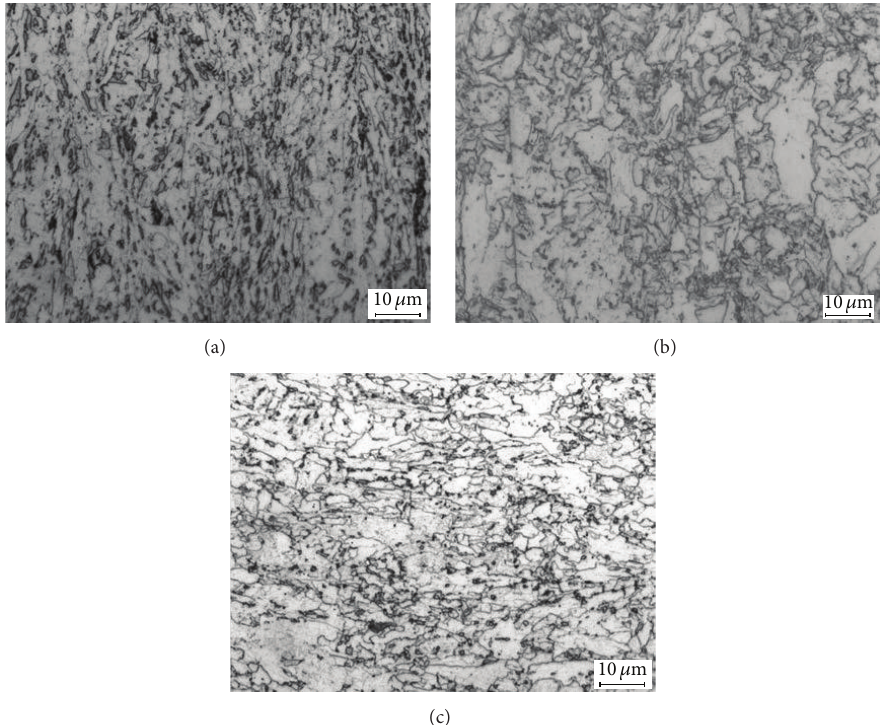
Figure 1: Optical micrograph of the microstructure for (a) X70, (b) X80, and (c) X100 pipeline steels.